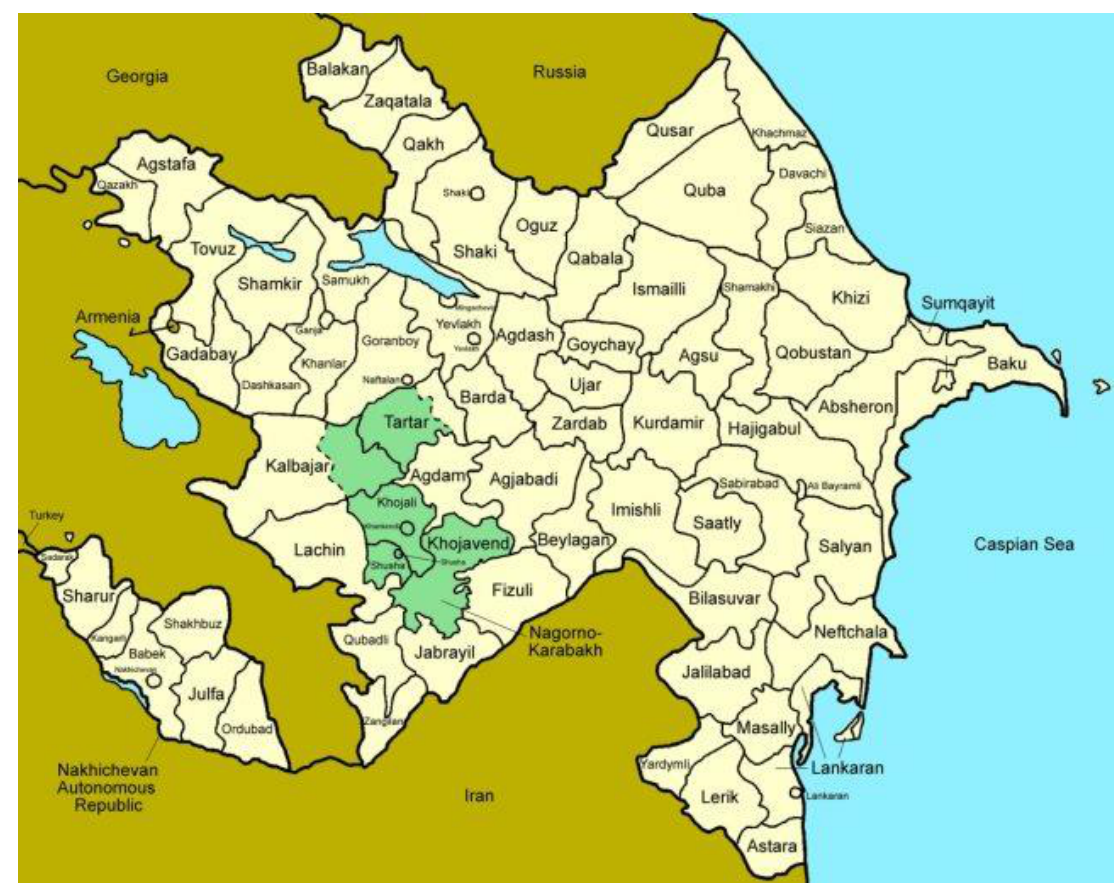
F IGURE 1. Map of regions of the Azerbaijan Republic